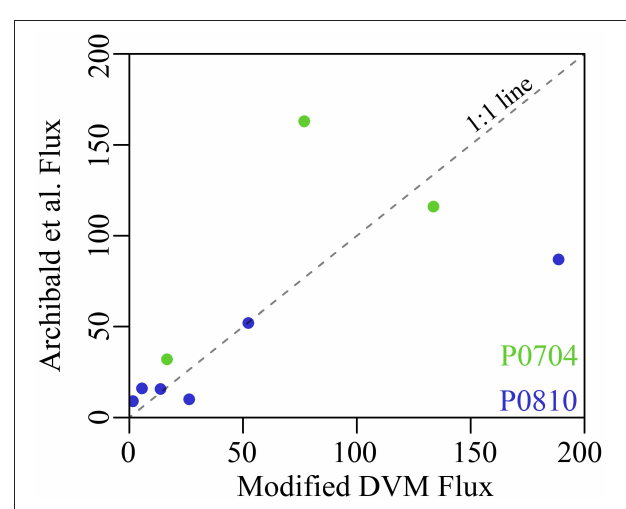
FIGURE 9 | Comparison between modeled mesozooplankton DVM flux without mesopelagic mortality and the predicted flux from Archibald et al. (2019) with CCE-specific parameterization following Stukel et al. (2015). Cruises are as colored (P0704 = green, P0810 = blue) and dashed line is a 1:1 reference line. Fluxes are shown in mg C m − 2 d − 1